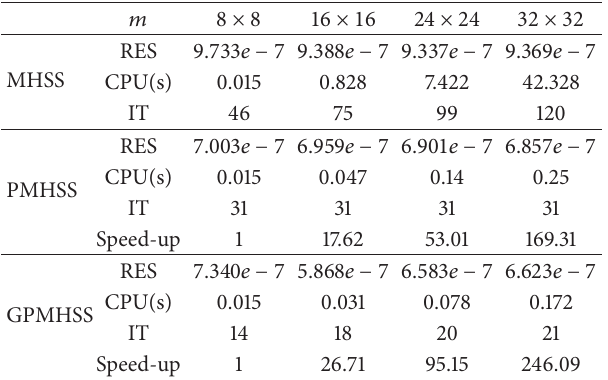
Table 4: RES, CPUs, and IT for MHSS, PMHSS, and GPMHSS with = 𝑃 = 𝑇 . 𝑃 = 𝑃 1 2